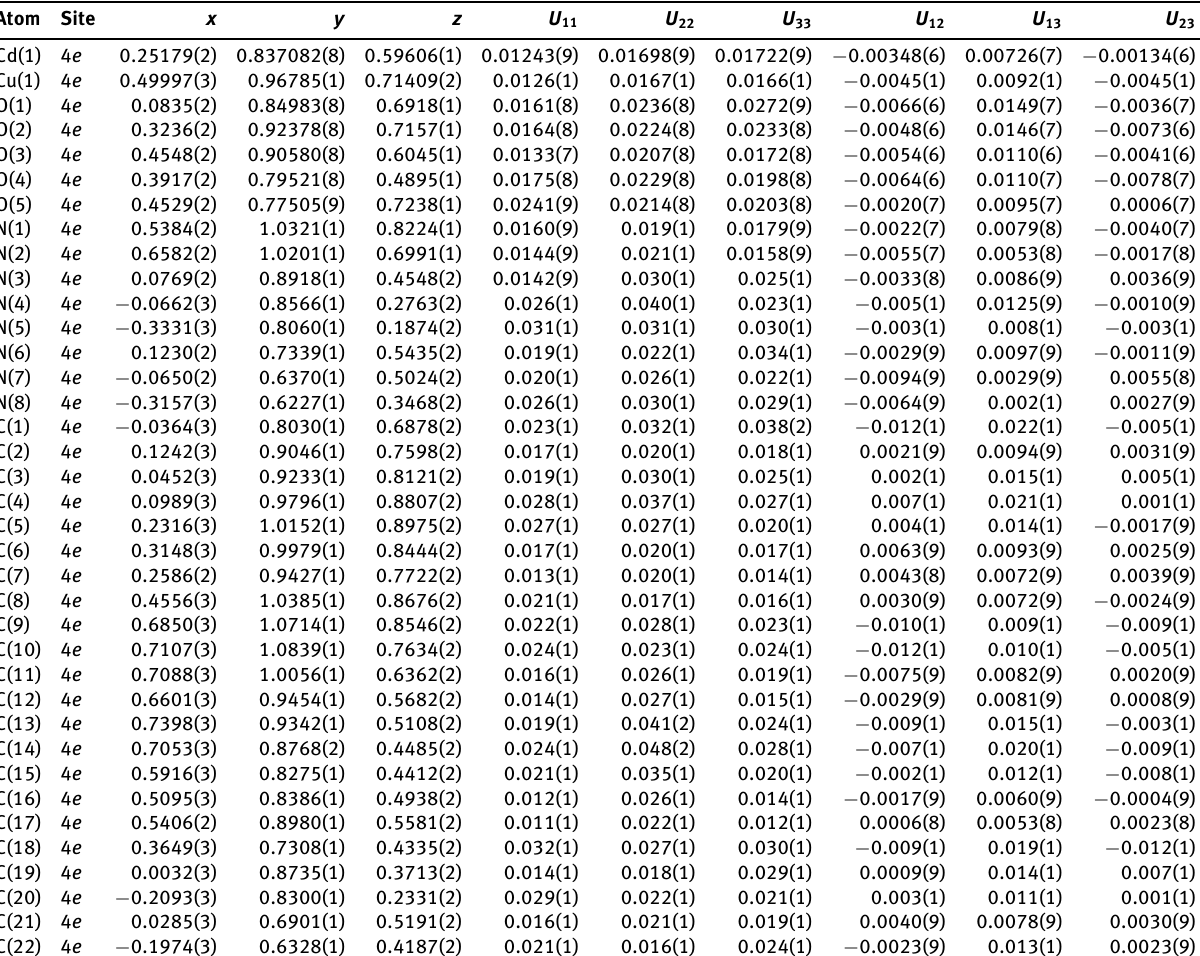
Table 3: Fractional coordinates and atomic displacement parameters (Å 2